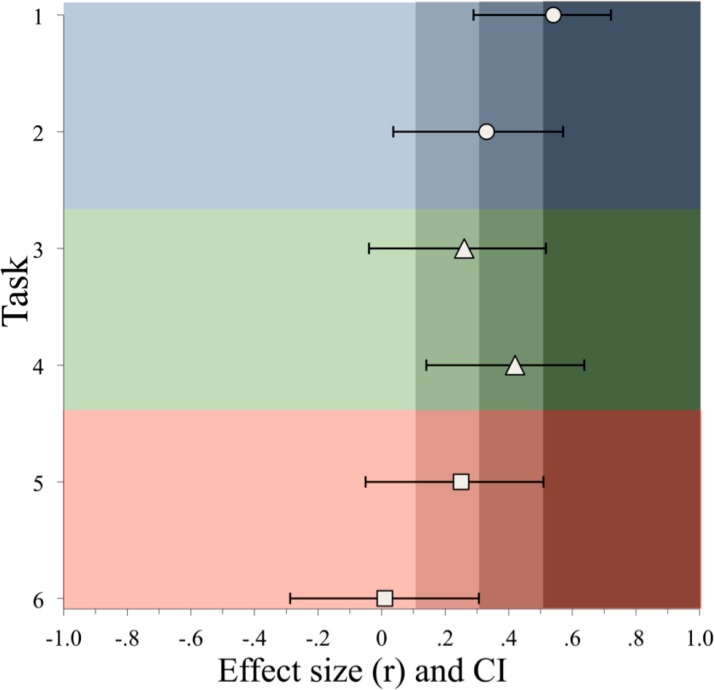
Effect size (r) with 95% CIs [84] for tasks measuring the memory for arbitrary and systematic aspects of the mappings for trained (tasks 1–4) and new items (tasks 5 and 6).Circles: arbitrary mappings (top to bottom: auditory translation recognition, cued recall). Triangles: arbitrary + systematic mappings in trained items (top to bottom: determiner selection, suffix recall). Squares: systematic mappings in new items (top to bottom: suffix only generalization, determiner + suffix generalization). The shaded areas indicate small (r = .10), medium (r = .30) and large (r = .50) effect sizes